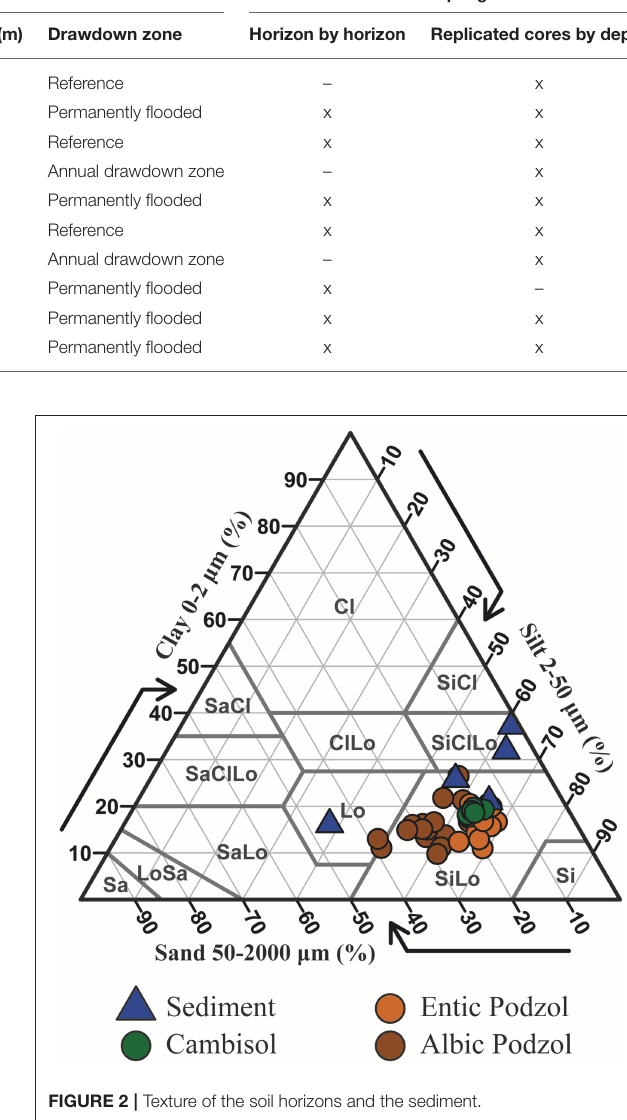
TABLE 2 | Main features of transects, sites and associated sampling effort. Transect Sites